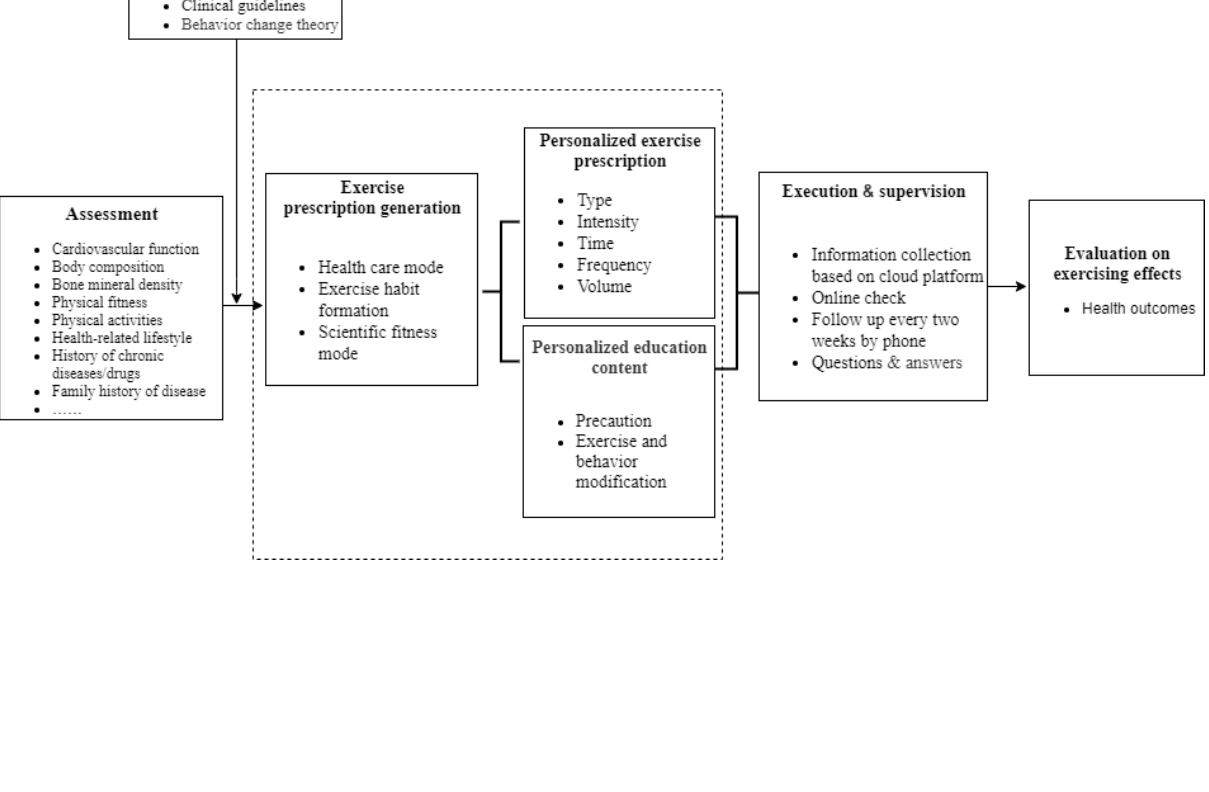
Figure 2. The assessment, exercise prescription generation, execution and supervision, and evaluation of exercising effects of the intelligent personalized exercise prescription program